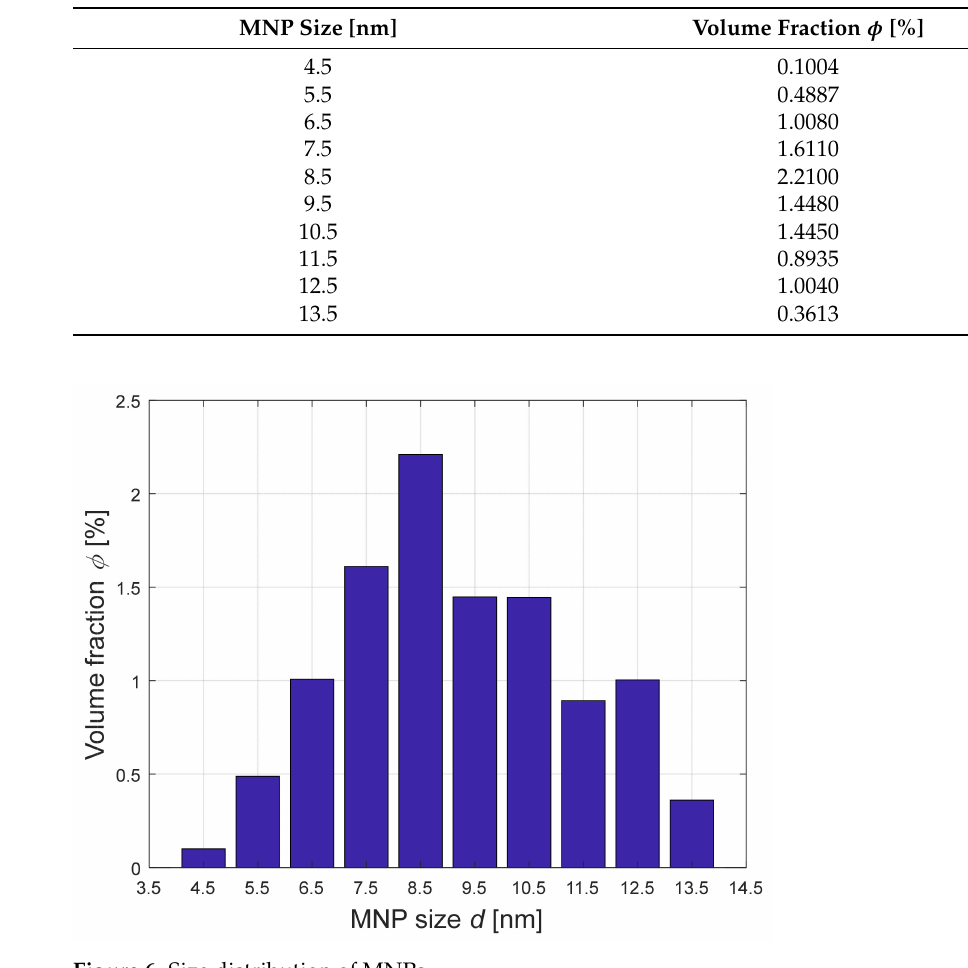
Figure 6. Size distribution of